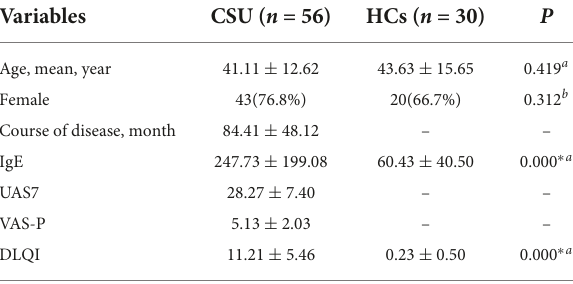
TABLE 2 Baseline characteristics of patients with CSU and